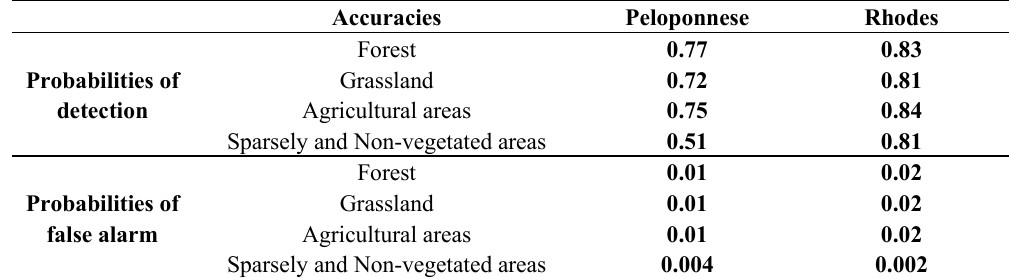
Table 3. Probabilities of detection (P areas for each land-cover.